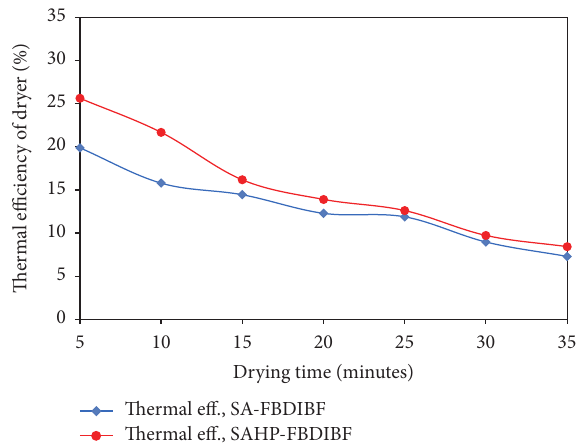
Figure 20: The variation of SEEC with drying time.